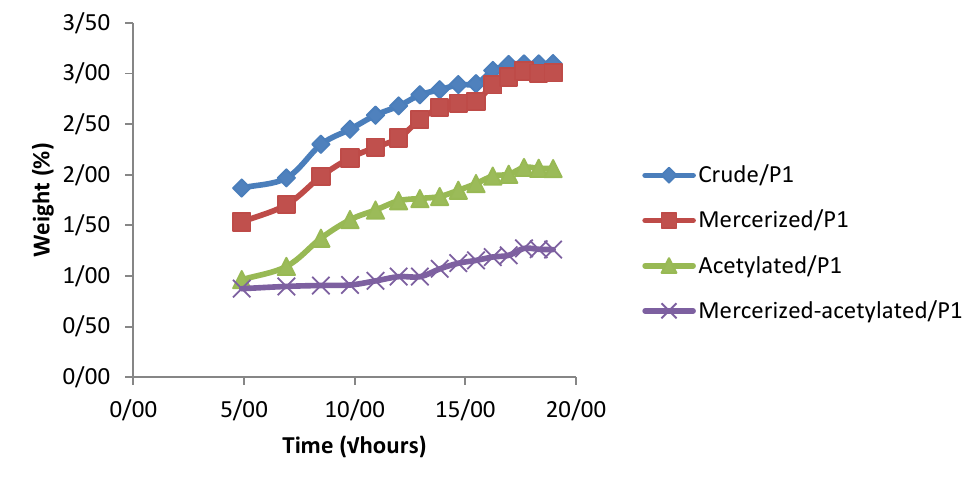
Fig. 1. Moisture absorption behaviour over time for P1 fibre